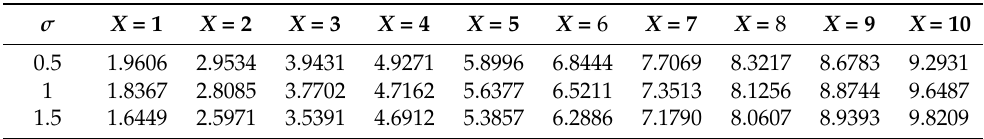
Table 8. Dependence of the value of the function f m ( X ) on the standard deviation parameter σ of the function f ( θ ) and the grade X in case 5, when µ = 8.5 , k = 1 .